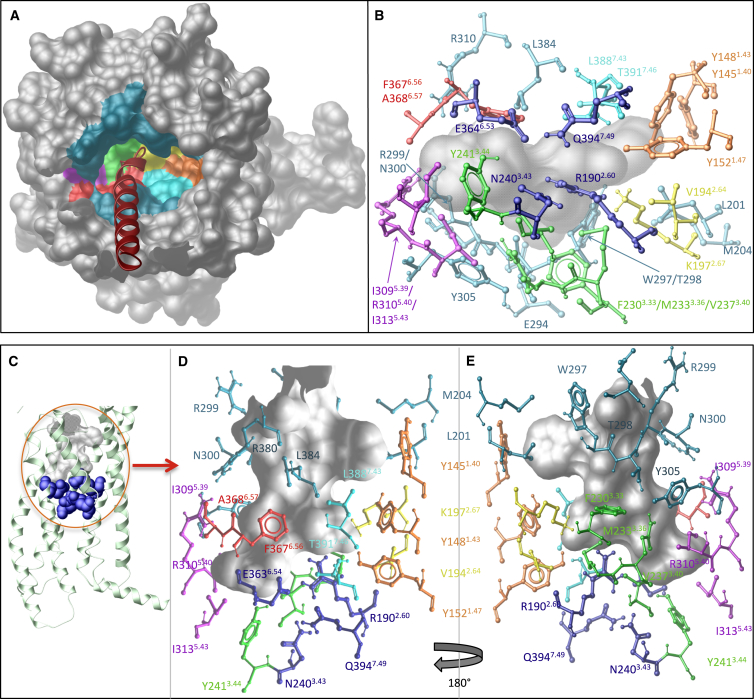
Modeling of the Predicted Peptide-Binding Cavity in the GLP-1R-GLP-1 Molecular Model, Related to Figures 1 and 3Molecular model of the GLP-1R-GLP-1 complex reveals the N terminus of the peptide binds in a deep cavity within the TM domain of the GLP-1R. (A) Surface representation of the GLP-1R TM domain viewed from the extracellular face (N terminus removed) highlighting the deep cavity within the TM bundle. Residues lining this cavity are contributed from residues in TM1 (orange), TM2 (yellow), TM3 (green), TM5 (purple), TM6 (red), and TM7 (pale blue). Residues located in the ECLs that line the entry to this cavity are shown in teal. (B), (D), and (F) highlight all the residues provided from these TMs and ECLs that surround the peptide binding cavity shown from three different angles (B from beneath the cavity, D and E from the side of the cavity, 180 degree rotated in E compared to D). Four class B conserved polar residues that reside in a hydrogen bond network in the inactive conformation lining the bottom of this binding cavity are highlighted in dark blue (B–E), where the cavity is shown in gray. The remaining residues are colored according to their location in the TMs using the colors depicted in (A).